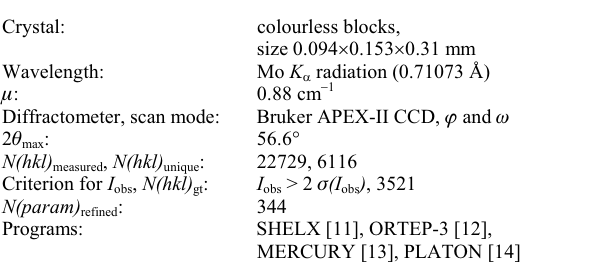
Table 1. Data collection and handling.